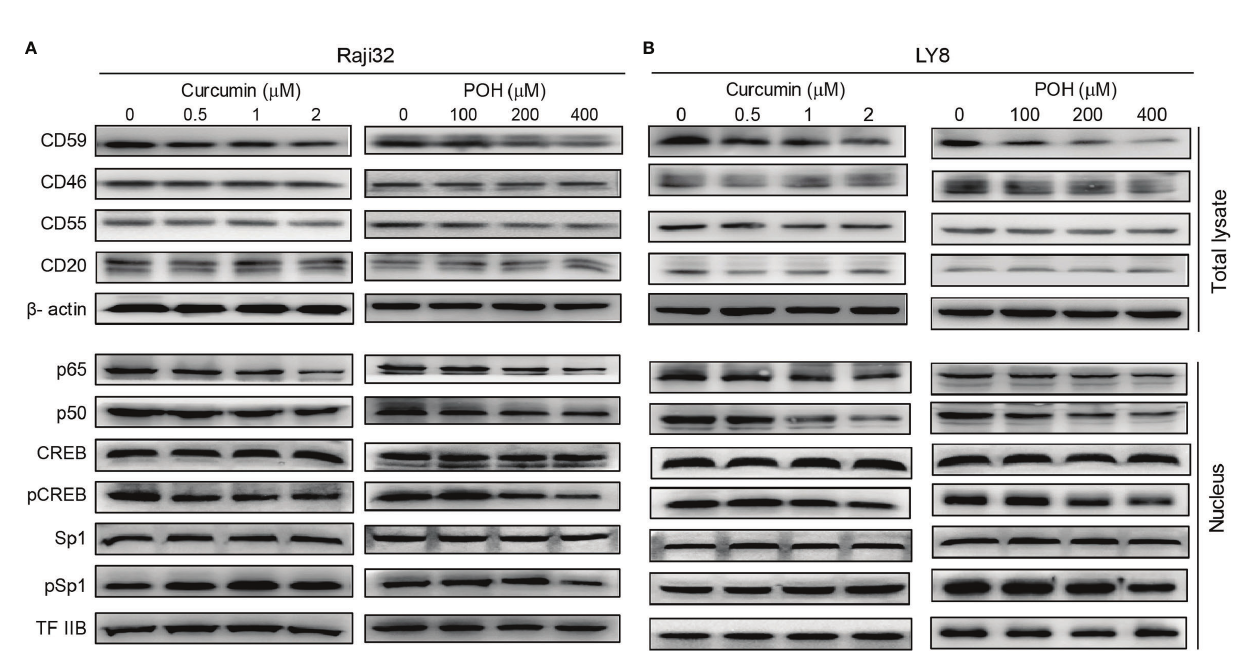
FIGURE 4 | The herbal products curcumin and POH suppress CD59 expression via inhibition of NF- k B and CREB. (A, B) Curcumin or POH inhibits the activation of NF- k B and CREB but not Sp1 and further reduces CD59 but not CD46, CD55 or CD20 expression in Raji 32 (A) and LY8 (B)